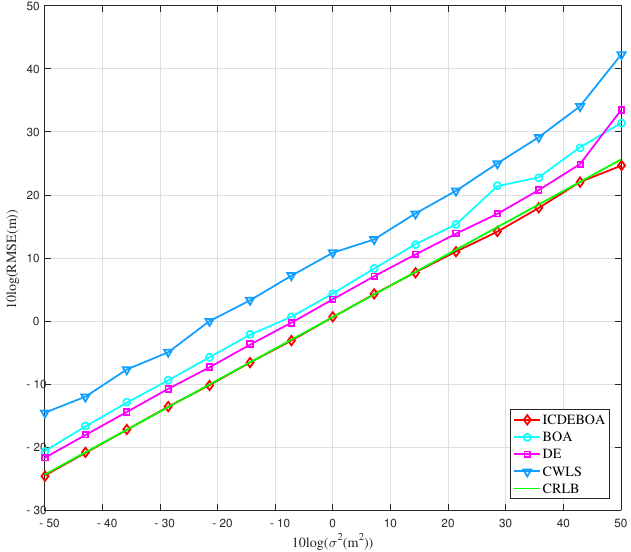
Figure 5. Plot of the obtained RMSE curves in relation to the measurement noise for second simula- tion